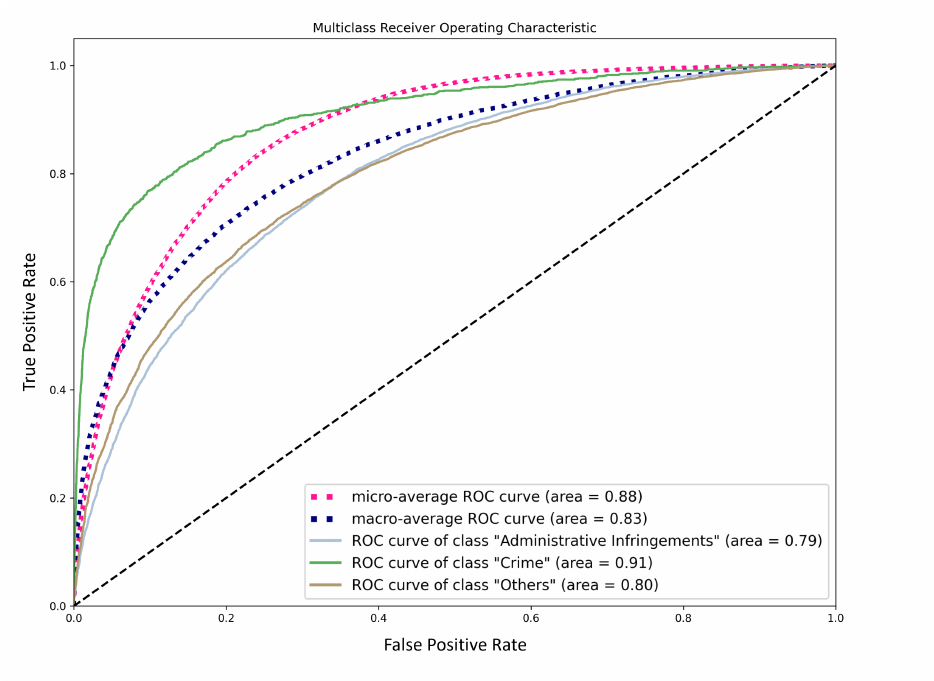
Figure 2. ROC curve for infraction severity prediction using SVM (3-class